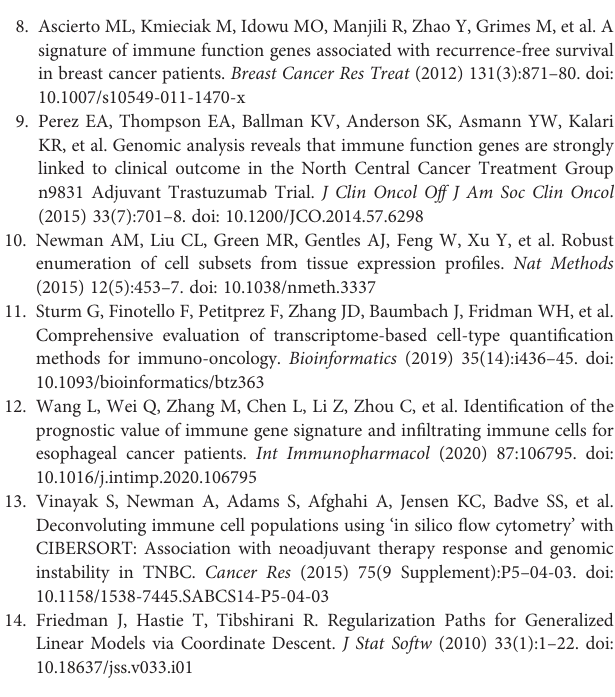
Supplementary Figure 1 | Violin plot of in fi ltrated immune cells between tumor tissues and paired normal tissues in the absolute mode of CIBERSORT analysis. The blue color represents the cancer tissues, and the red color represents the paired tumor tissues. The inner violin plot shows the quartile, median, and third quartile. Supplementary Figure 2 | Relationship between the IPS score and overall survival in ESCC. Log(HR) plots of the overall survival rate in the IPS-high and IPS- low groups are shown. Note: *, ** the number of patients in the subgroup was too small, so the result for the log(HR) plots was beyond the − 5 to 5 limit. Supplementary Figure 3 | The overall survival-predictive effect of M2 macrophages in the GEO training set (A) , the TCGA validation set (B) , and the IHC set (C)